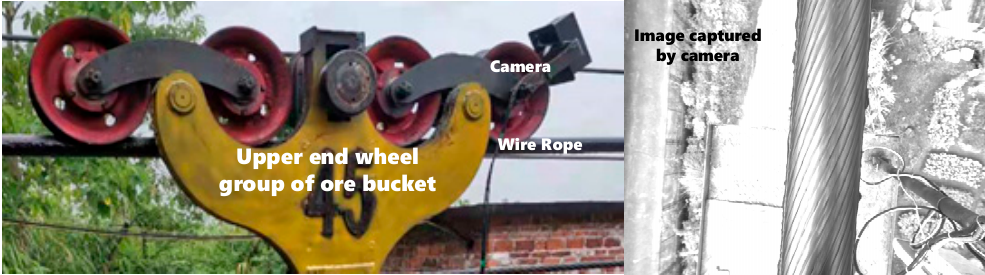
Figure 6. The environment of wire rope image acquisition.